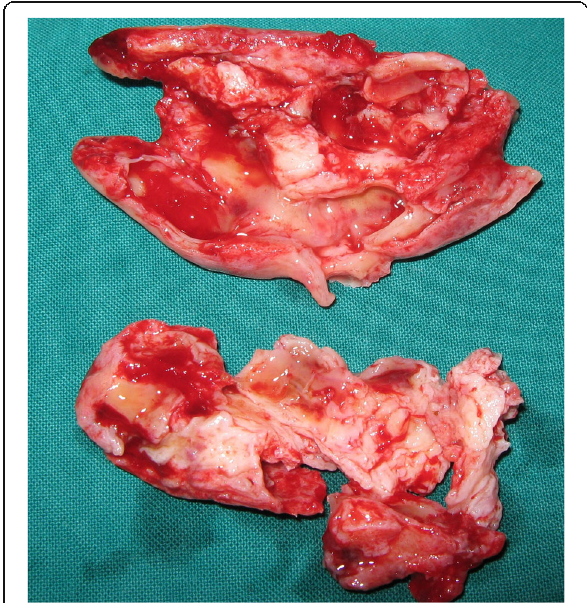
Fig. 5 Specimen after resection showing huge cavity within turbinate